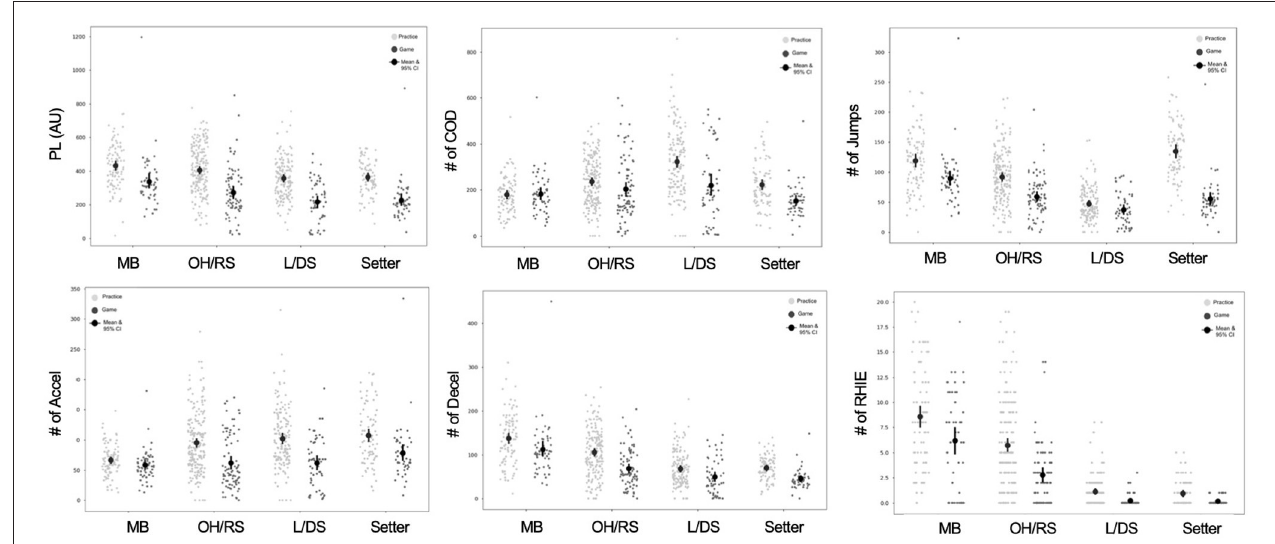
FIGURE 8 | Accelerometry variables by position and session type. Each point on the graph represents an individual player-session. MB, middle blocker; OH/RS, outside hitter/right side hitter; L/DS, libero/defensive specialist; PL, playerload; COD, change of direction; accel, accelerations; decel, decelerations; RHIE, repeated high intensity